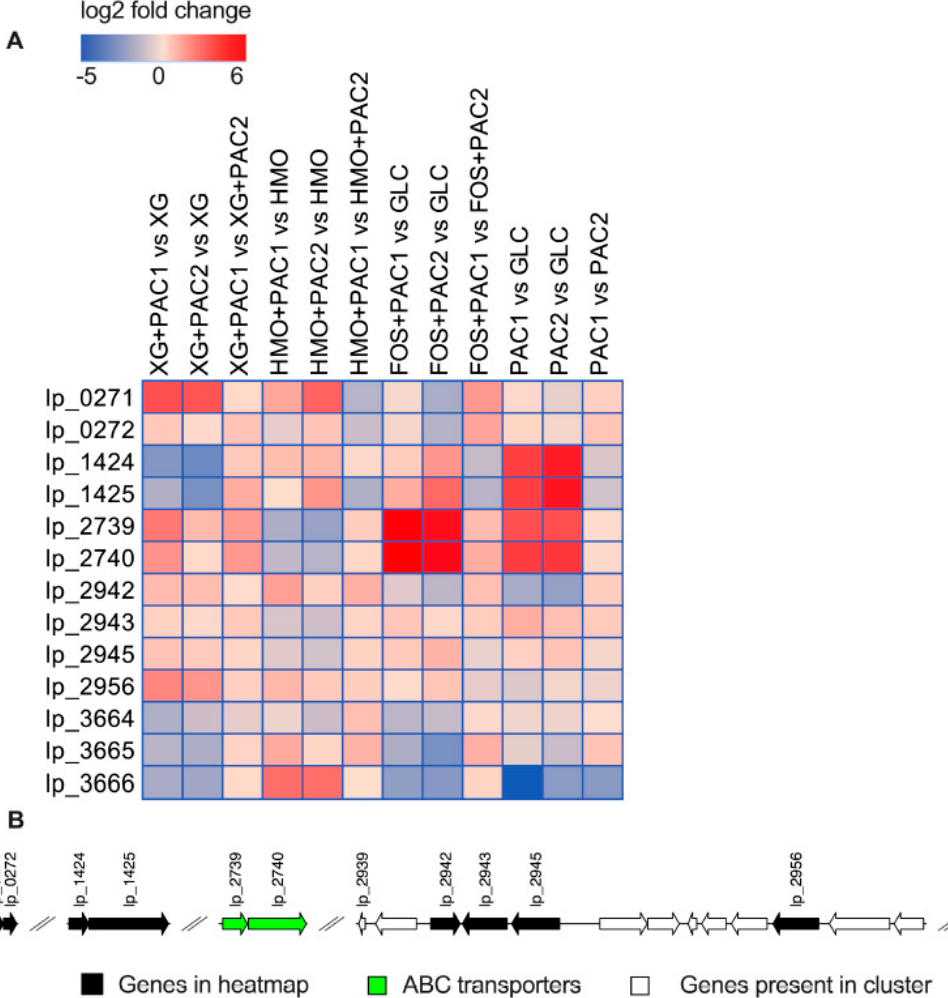
Figure 6. Relative gene expression of the predicted polyphenol metabolism genes within the global transcriptome. The log 2 fold change gene expression from independent biological duplicates was performed from raw reads using the R package DESeq2 and is depicted in the heatmap ( A ). Potential genomic clusters involved in L. plantarum polyphenol utilization ( B ).